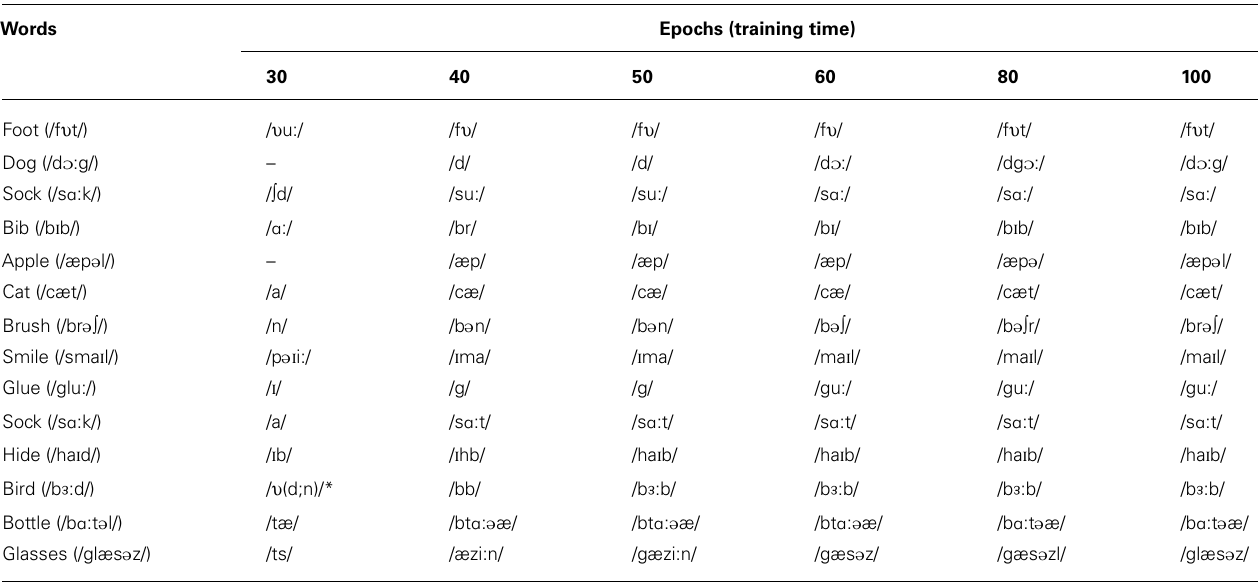
Table 1 | Sample production errors from DevLex-II in learning English